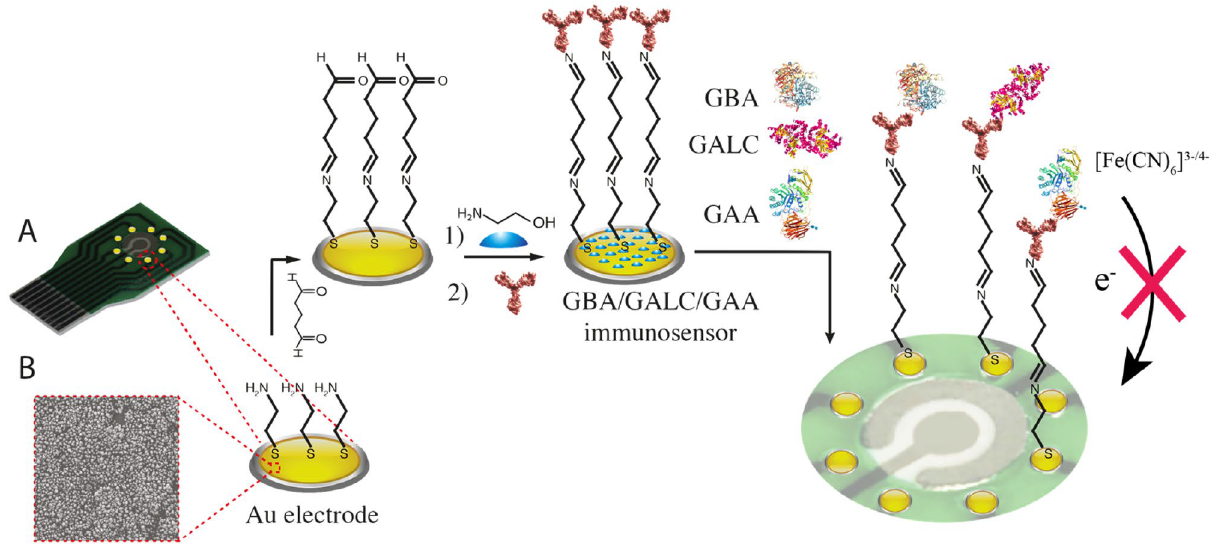
Figure 1. Schematic diagram of the fabrication steps and detection mechanism of the multiplexed immunosensor for GAA, GBA and GALC ( A ). SEM image of an electrode after electrodeposition of AuNPs via chronoamperometry ( B ). The AuNPs-modified electrodes were then functionalized with cysteamine to form SAMs, followed by glutaraldehyde as crosslinker. The binding of the to the antibodies hinders the access of the solution-based redox probe to the electrode surface (red